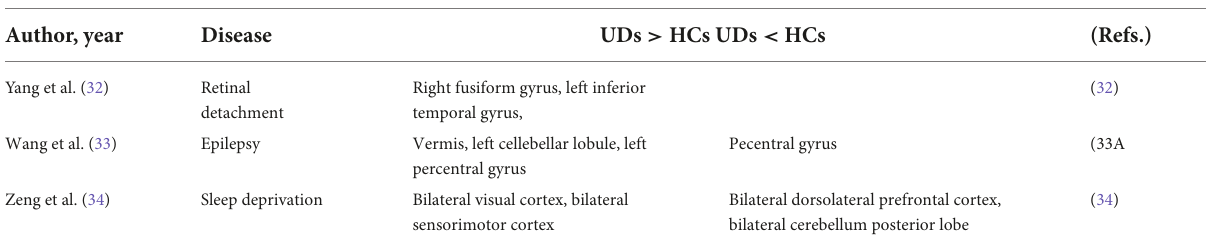
TABLE 4 Brain areas alternation and its potential functions. HC, healthy controls; MB, monocular